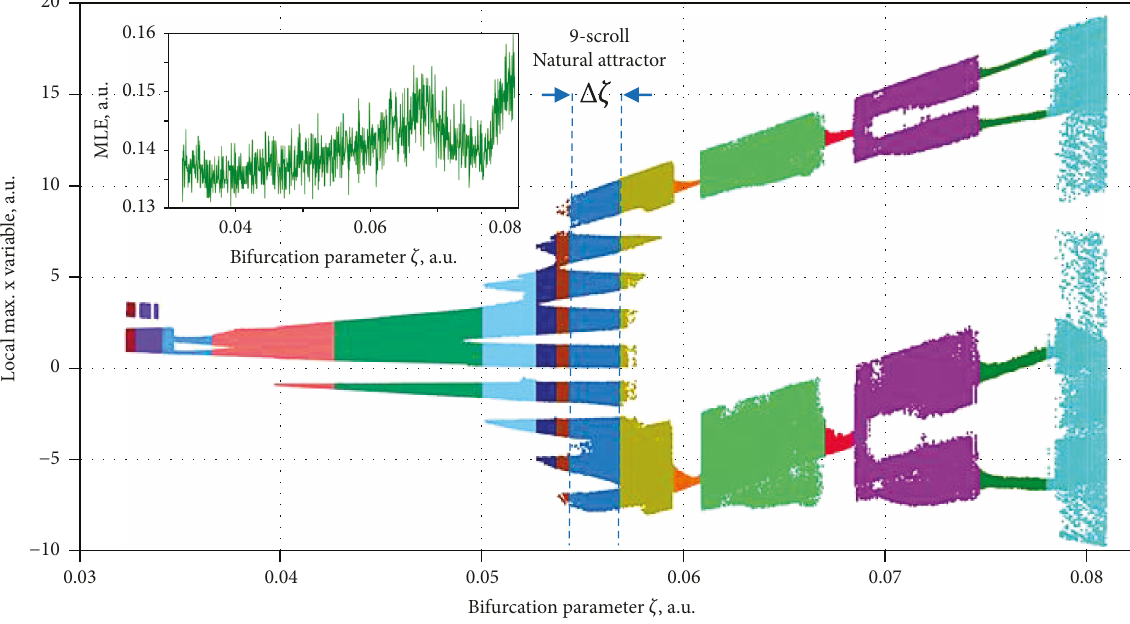
Figure 4: Bifurcation diagram for the dynamical control parameter α = 0 45 .